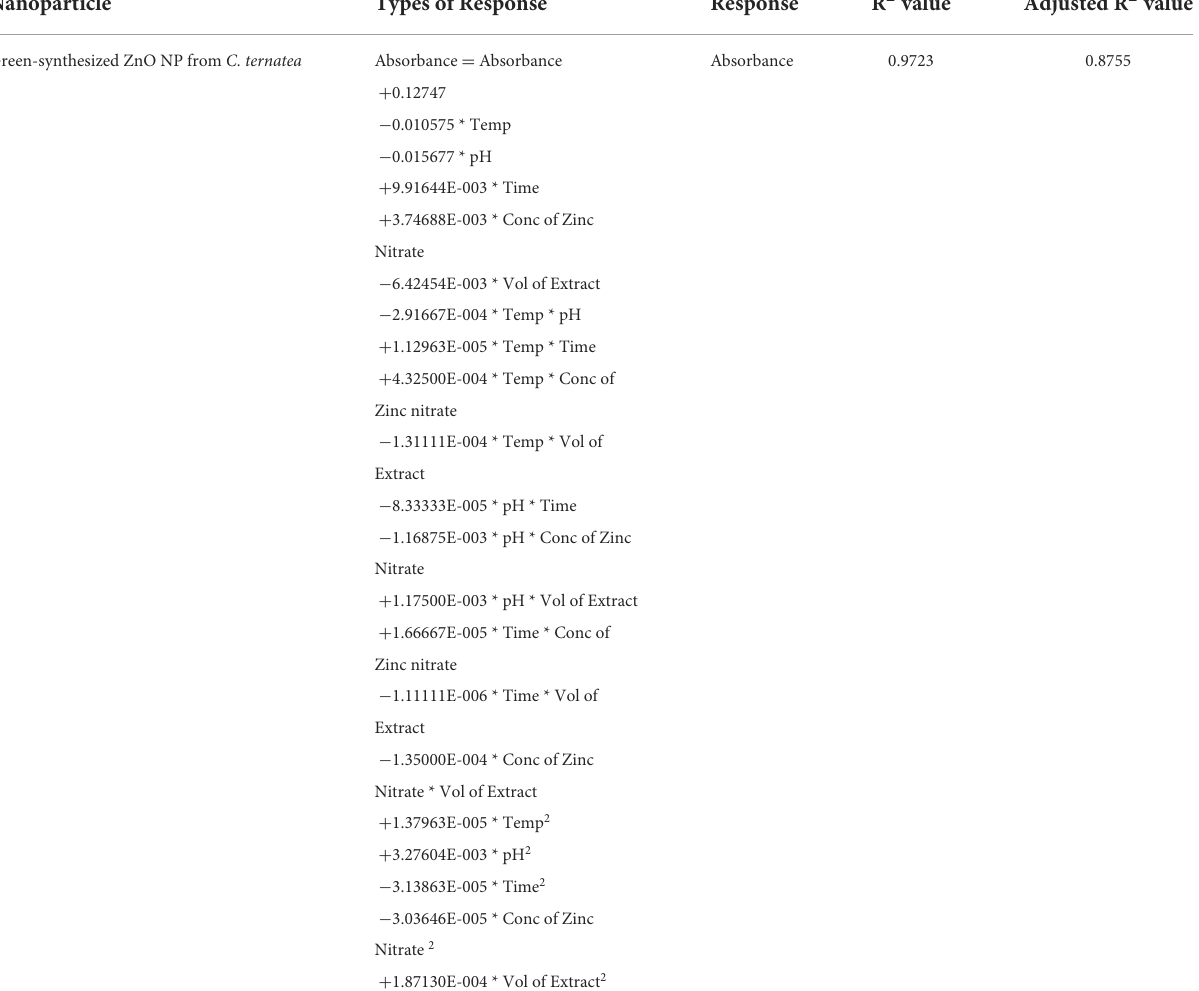
TABLE 3 RSM optimization model for optimizing the green synthesis of ZnO NPs from C. ternatea . Nanoparticle Green-synthesized ZnO NP from C.